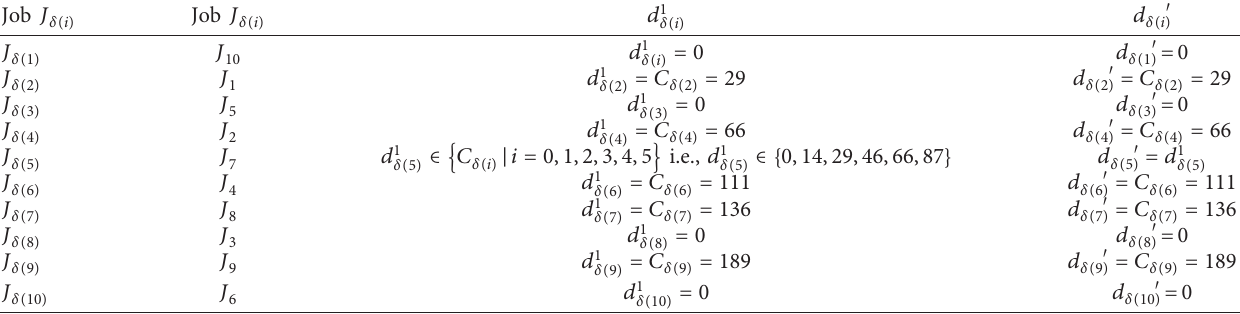
Table 1: Results of the optimal due-window location.